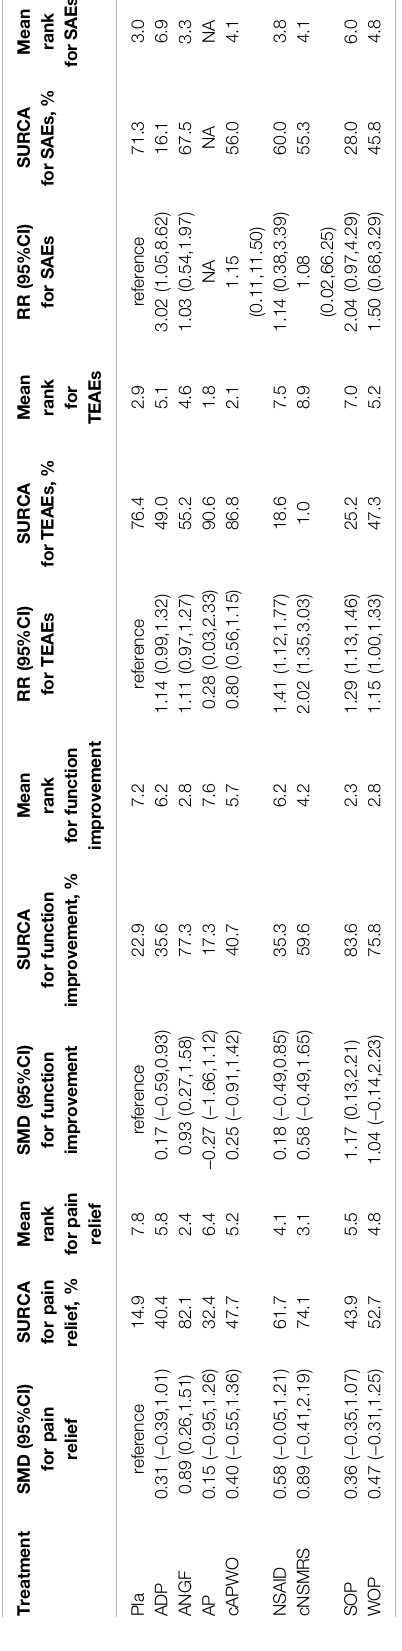
( Supplementary Figure S7 ) or node-split tests ( Supplementary Figure S8 ), consistency models were used in both networks. No publication bias was found in either effect endpoint network. Based on the SUCRA ranking, ANGF had the largest probability of being the best analgesic for LBP (SUCRA